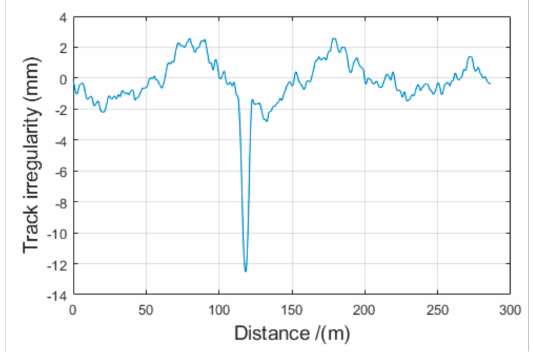
Figure 8. Track irregularity after overlaying.